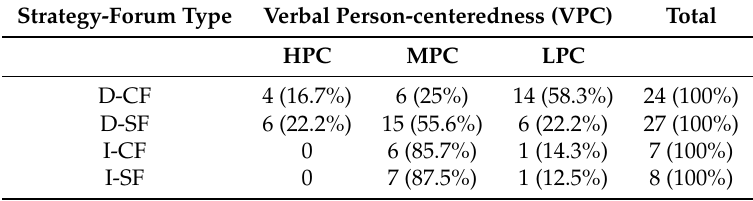
Table 11. Seeking strategy and level of VPC of emotional support provided (D = Direct; I =